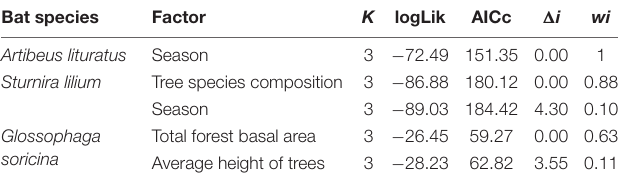
TABLE 2 | Results of Akaike information criterion (AIC)-based model selection, assessing the association between the proportion of females to males of three bat species with seasonality and vegetation